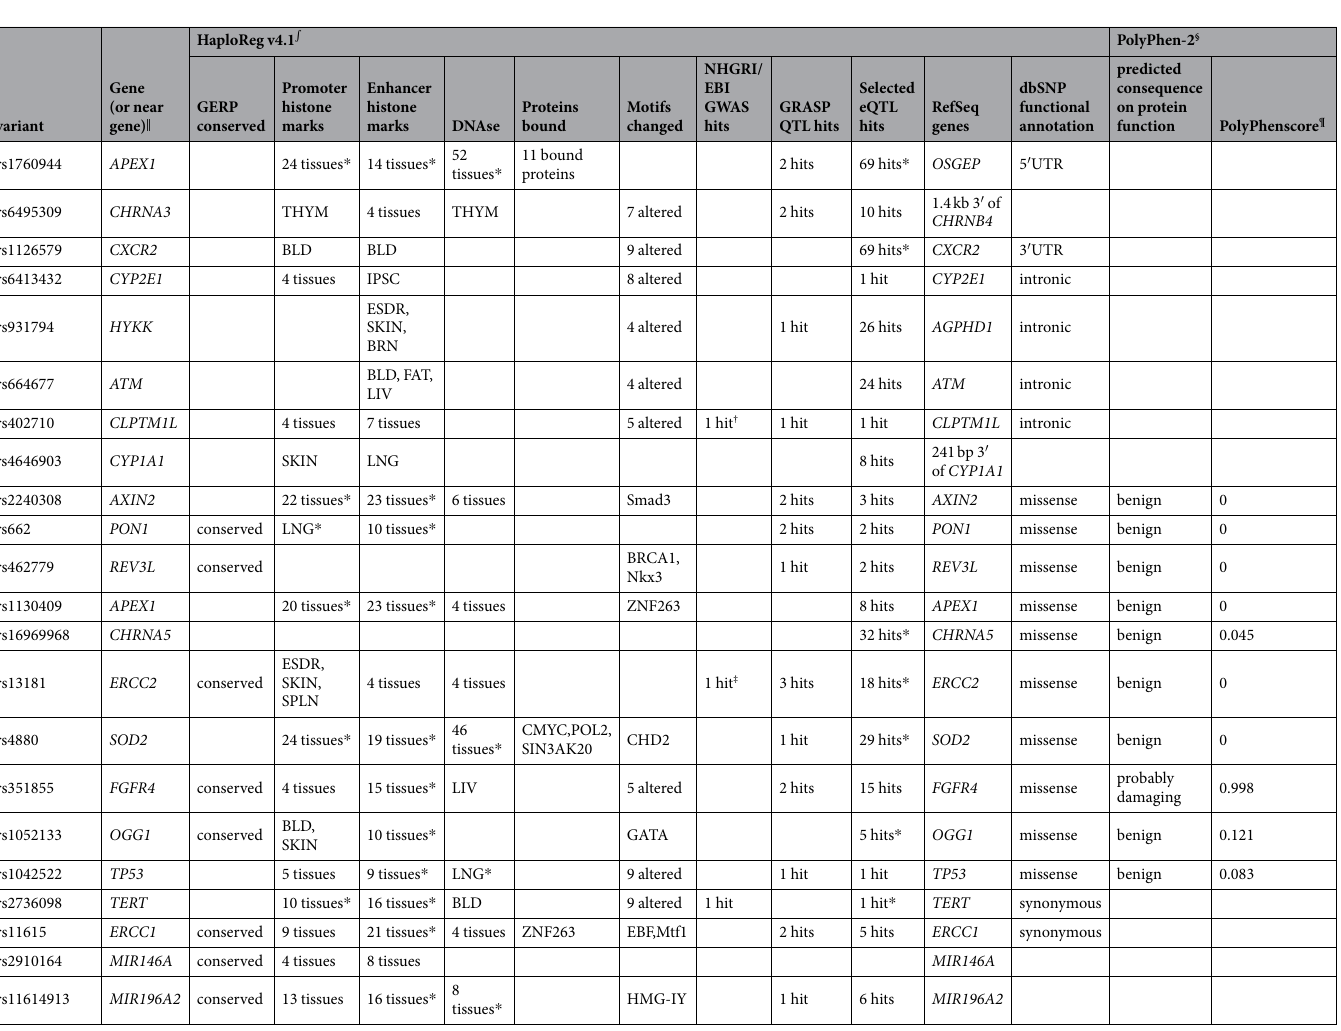
Table 4. Functional annotation of 22 variants associated with lung cancer risk with strong evidence using HaploReg v4.1 and PolyPhen-2. ǁ The gene name for the SNP, locating in a respective gene, was based on the annotation of dbSNP database (https://www.ncbi.nlm.nih.gov/snp/). The near gene name for a SNP that didn’t map into a gene region but its location nearby a gene based on the annotation of dbSNP database, and we also used this nearby gene name for the SNP in our study. ∫ HaploReg v4.1: a Web server for annotation of transcription regulation for genetic variants (http://archive.broadinstitute.org/mammals/haploreg/haploreg. php). § PolyPhen-2: a Web server for annotation of potential effects on protein structure and function for non-synonymous SNPs (http://genetics.bwh.harvard.edu/pph2/). ¶ The PolyPhen-2 reported a score that the calculated naive Bayes posterior probability of a given mutation being damaging ranging from 0 to 1, which was also classified as benign [0, 0.15], possibly damaging (0.15, 0.85], and probably damaging (0.85, 1], respectively. * Including regulatory evidence in lung cancer cell lines/tissues or normal lung cell lines/tissues. † GWAS for the trait of lung cancer with a P-value at 4.0 × 10 − 6 . ‡ GWAS for the trait of lung cancer with a P-value at 9.0 × 10 − 7